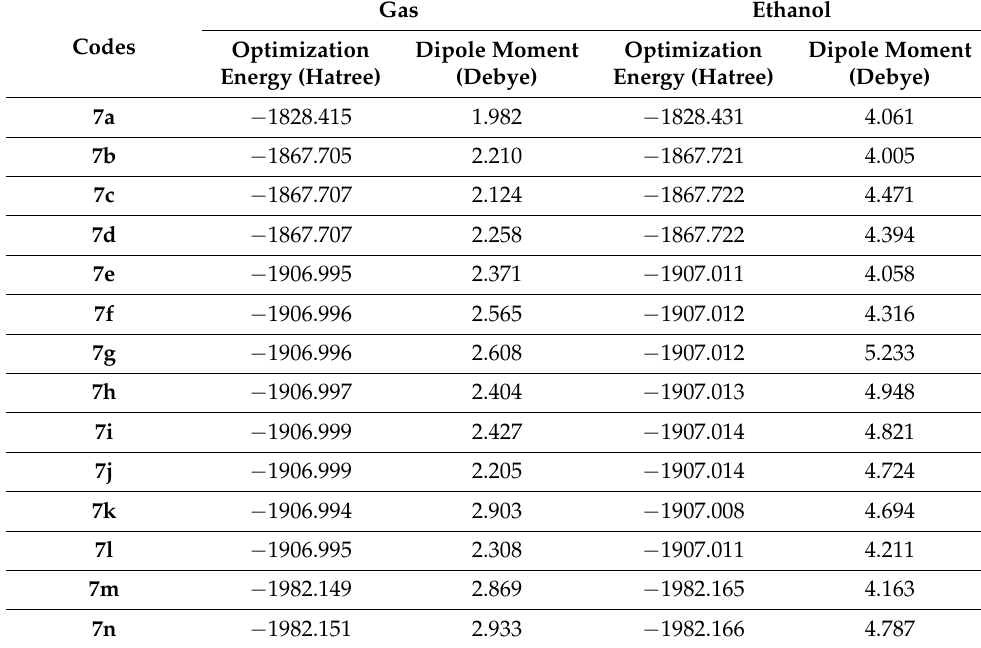
Table 1. Optimization energy and dipole moment of selected compounds in gaseous and solvent phase.